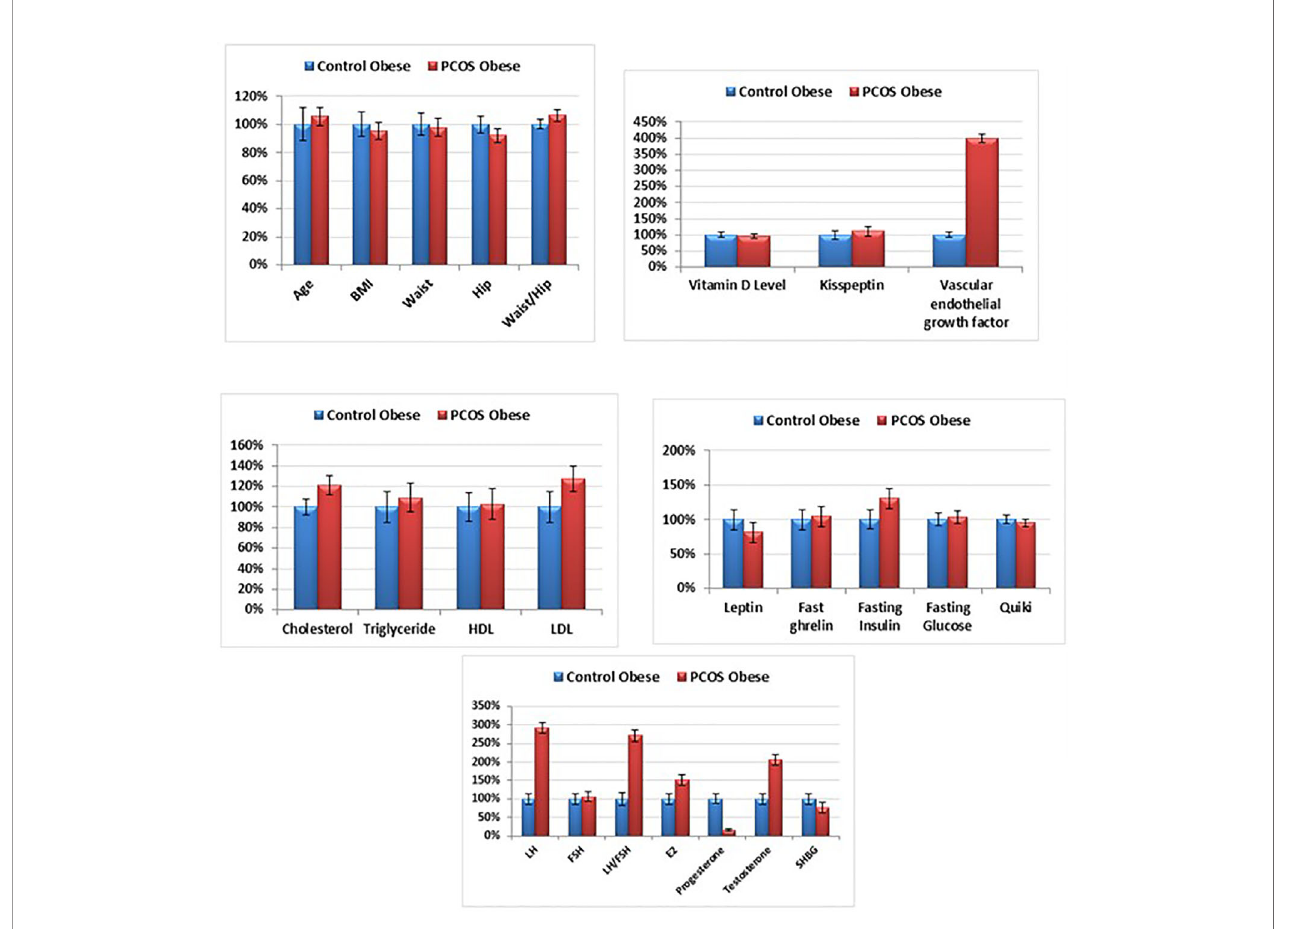
FIGURE 1 | Percentage change of all studied parameters in obese PCOS group compared to the obese control